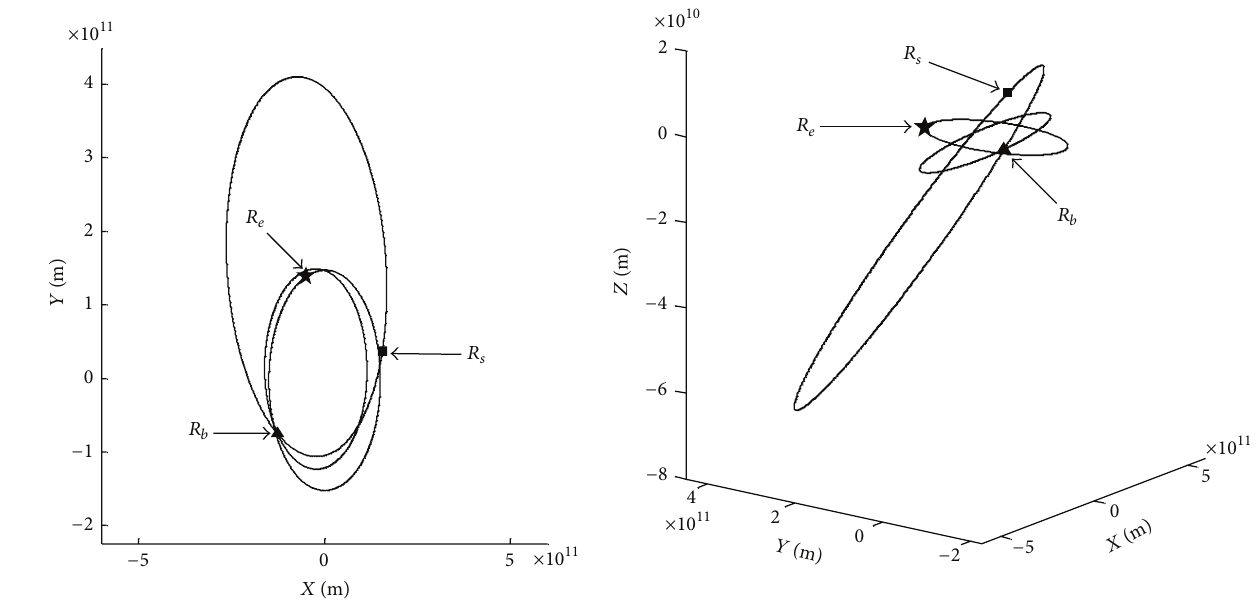
Figure 2: Ends of vectors 𝑅 𝑒 , 𝑅 𝑠 , and 𝑅 𝑏 .